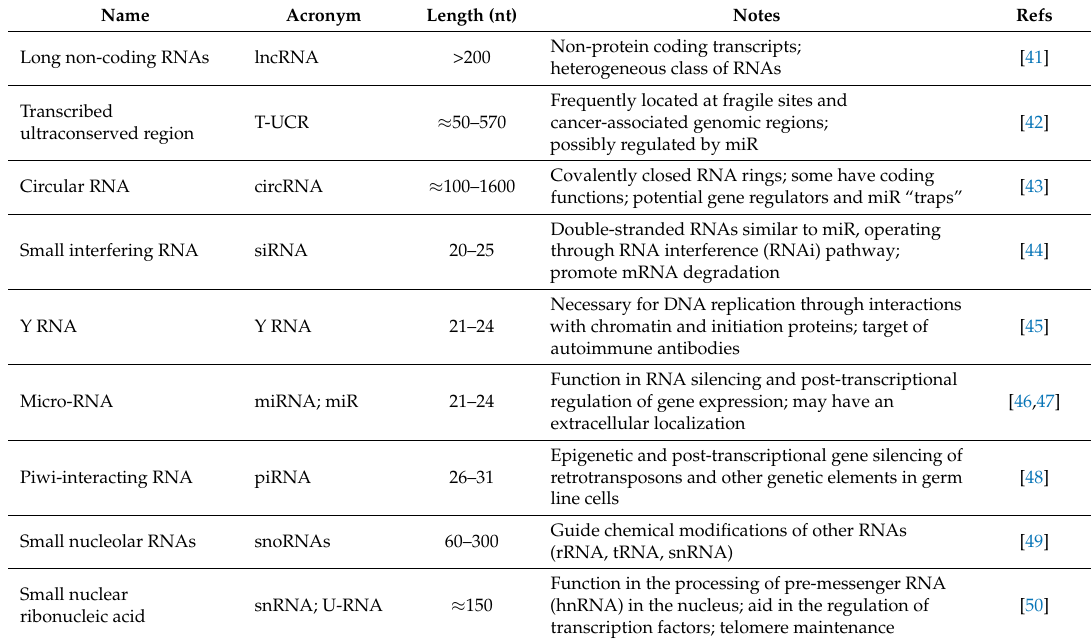
Table 1. Main non-coding RNA (ncRNA) classes, listed according to increasing length (in nucleotides